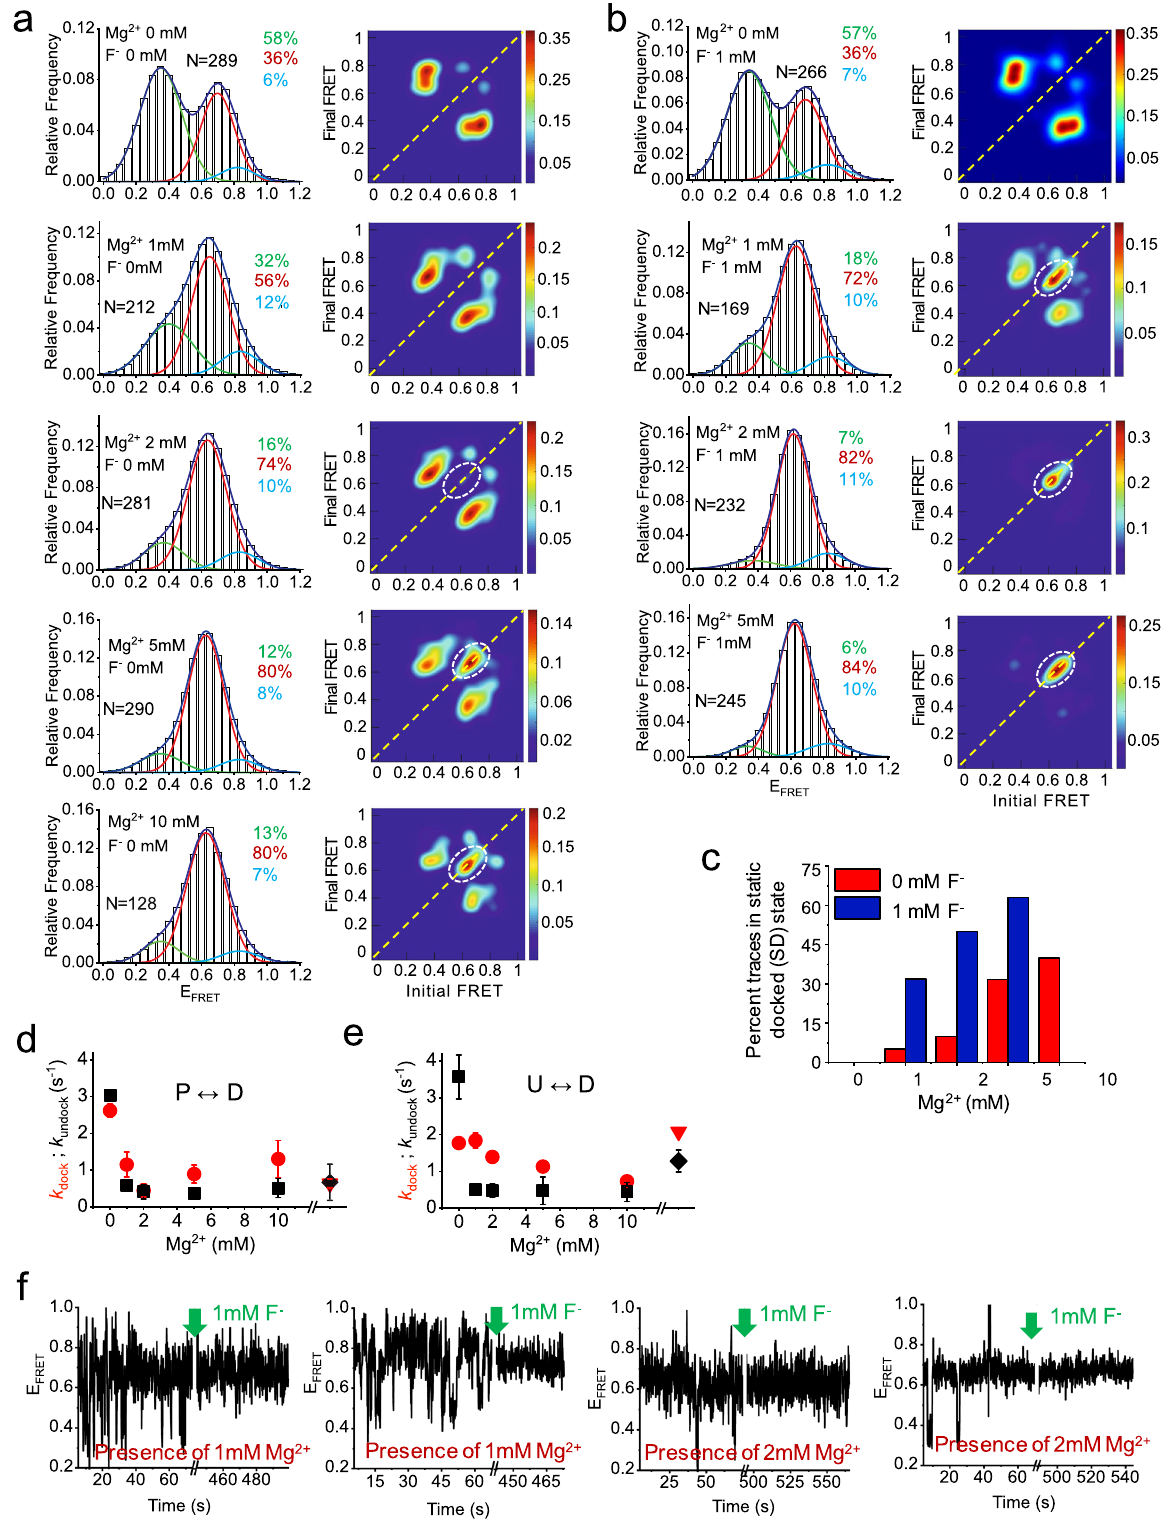
in the TODP (Fig. 2a, b). At a more physiological 1 mM Mg 2 + , only 4% of traces reside in this static D state, rising to 30% and 38% in the presence of 5 mM and 10 mM Mg 2 + , respectively (Fig. 2c). These data indicate that the fl uoride riboswitch transiently interconverts between docked and undocked con- formations in the absence of Mg 2 + , and increasingly adopts